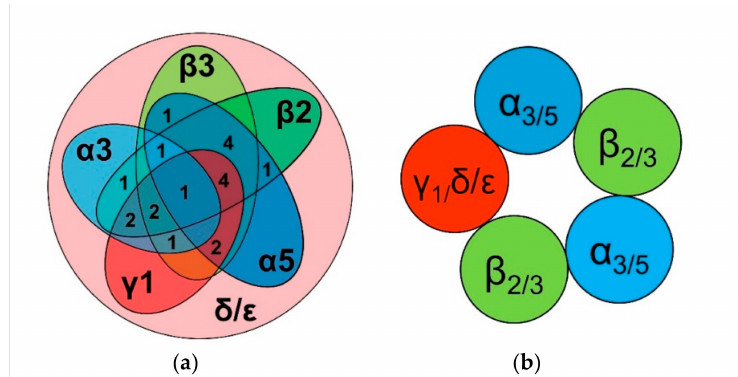
Figure 7. Overlap of expression of transcripts encoding GABA A receptor subunits within individual ACC tumors. ( a ) Venn diagram representing the number of potential receptor-expressing tumors with > 3 log 2 RSEM transcripts encoding the indicated subunits. ( b ) Depiction of potential pentameric GABA A receptor subunit configurations based on most prevalent subunit-encoding transcripts.